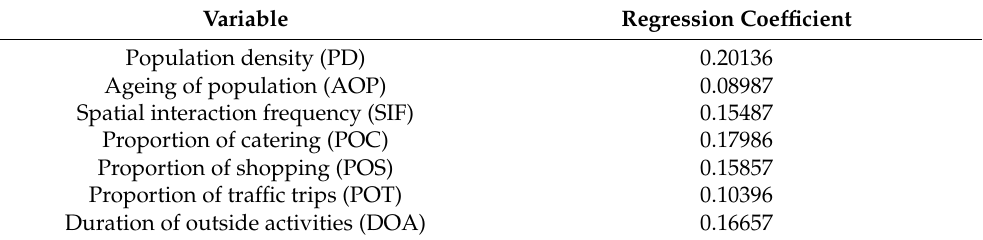
Table 7. Regression coefficient of COVID-19 morbidity rate with demographic and activity